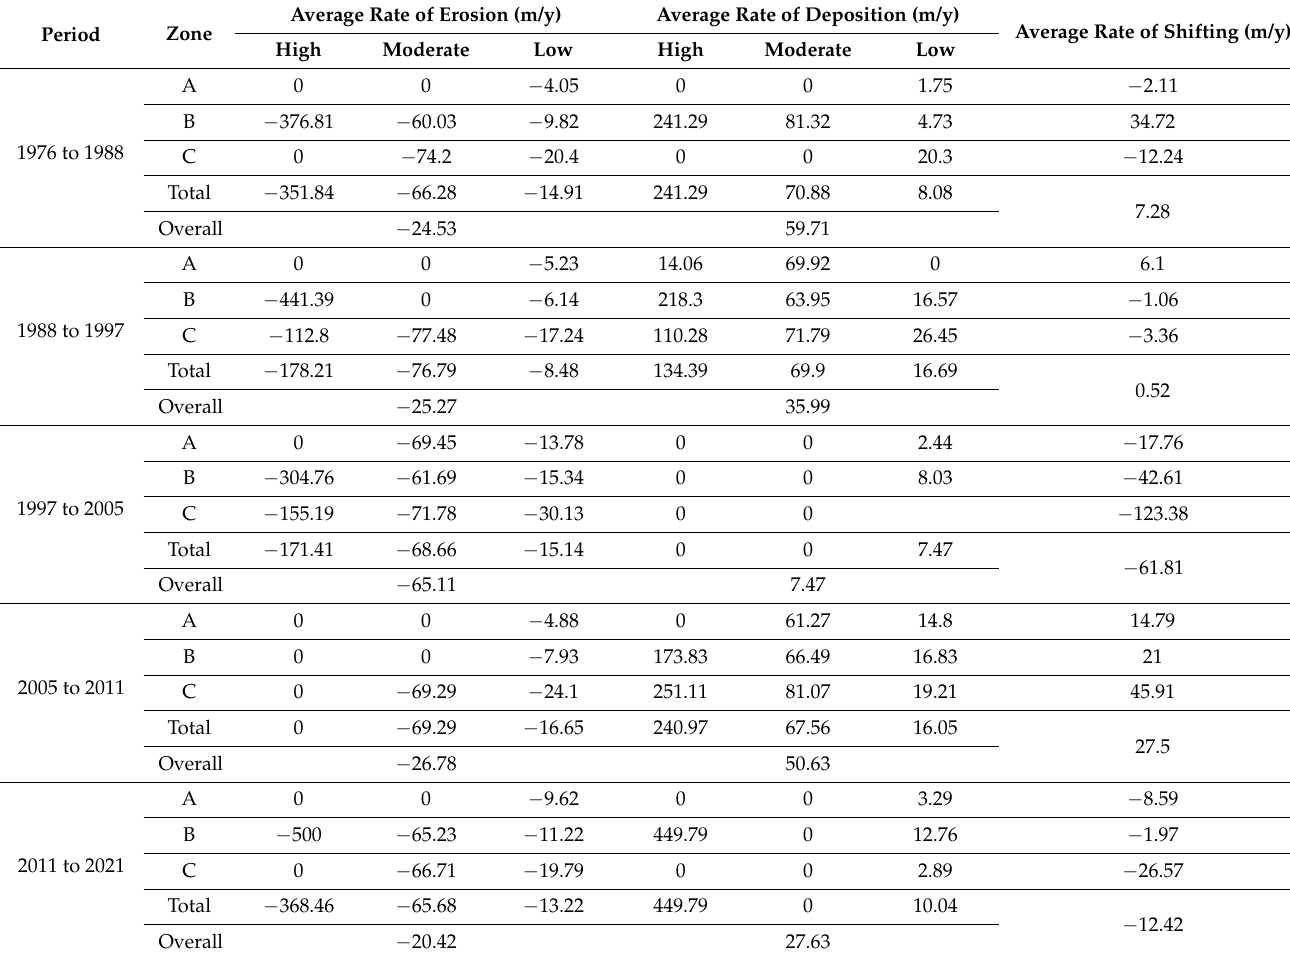
Table 3. Right bank shifting rate of the Jia Bharali River using EPR approach of DSAS